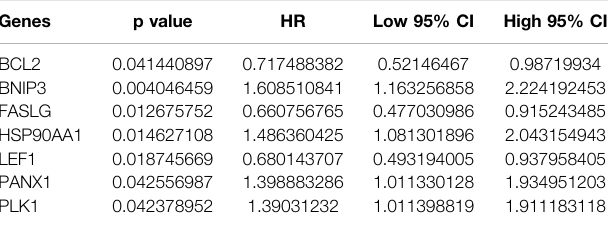
TABLE 3 | Necroptosis genes with prognostic signi fi cance in progression-free survival analysis.